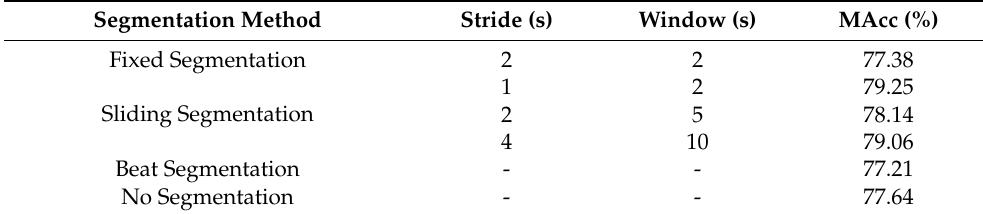
Table 1. Comparison of segmentation methods.